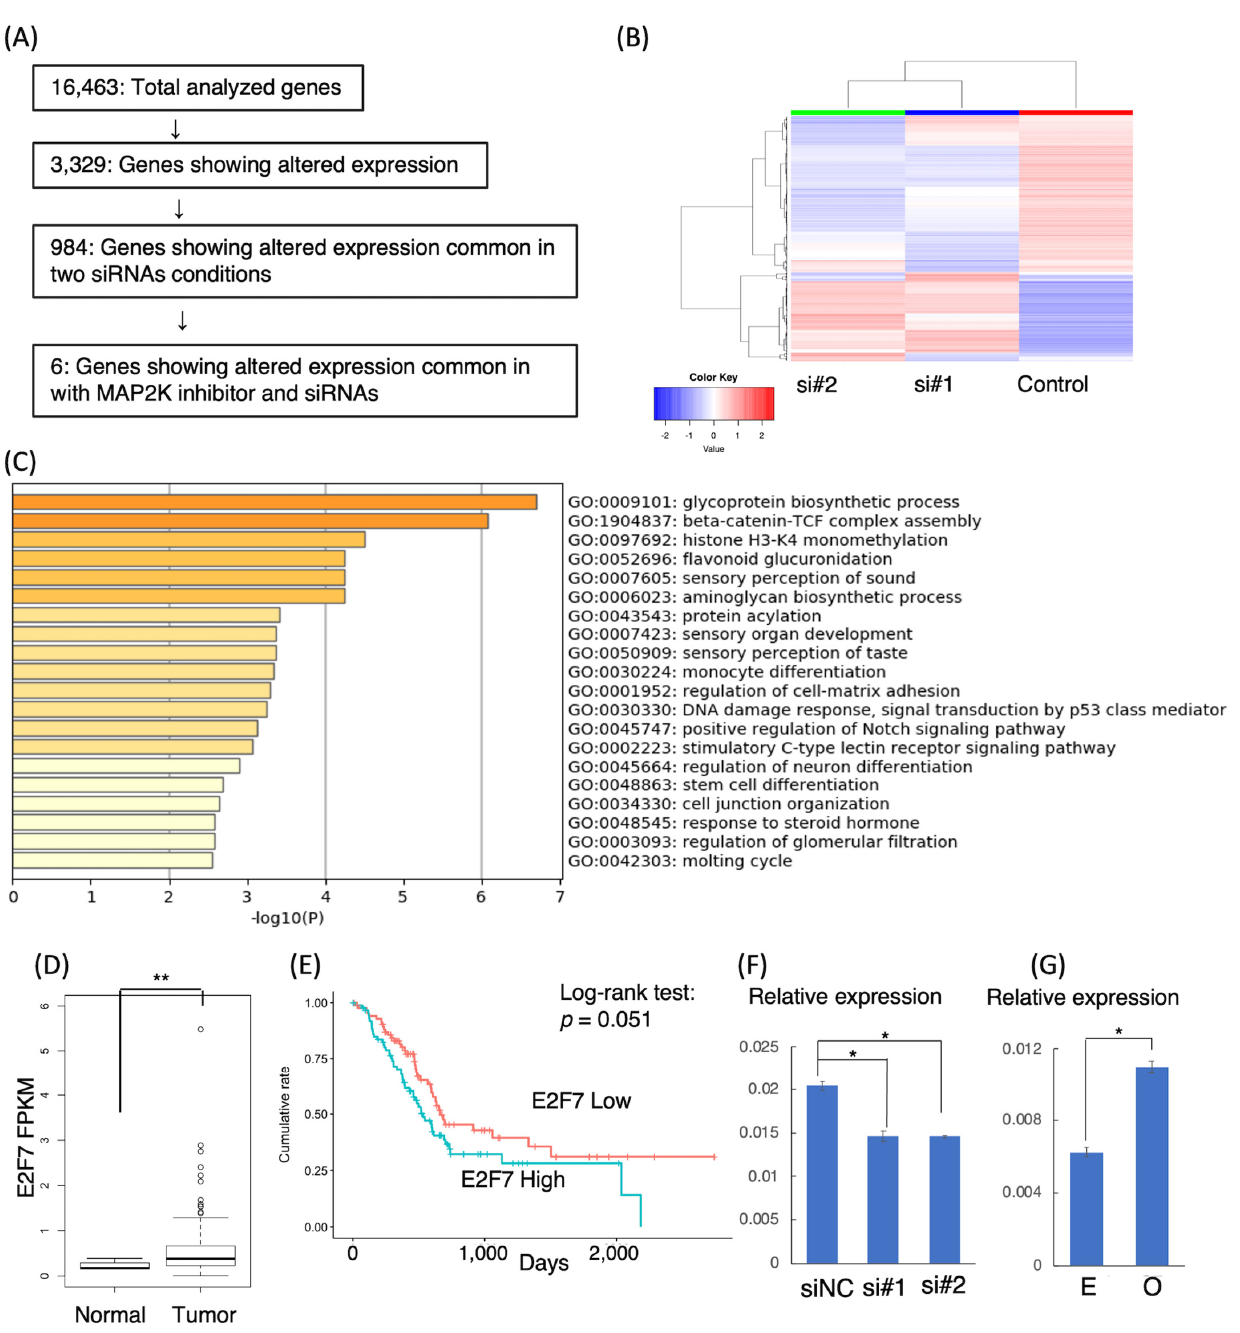
Figure 4. Identification of genes associated with LINC00941. ( A ) Stringent processing of comparative transcriptome sequencing data of AsPC-1 with or without attenuation of the expression of LINC00941 . ( B ) Heatmap with hierarchical clustering showing comparison of transcriptome data between cells with siRNAs for LINC00941 and negative control. ( C ) Top 20 Gene Ontology Biological Process terms of genes associated with LINC00941. ( D ) TCGA data analysis showed that pancreatic cancer tissues revealed higher expression of E2F7 than normal tissues (** p < 0.001). ( E ) TCGA data analysis showed the marginal survival difference between patients with pancreatic cancer with higher and lower expression of E2F7 ( p = 0.051 by log-rank test). ( F ) qRT-PCR validated the transcriptome data showing downregulation of E2F7 by knockdown of LINC00941 in AsPC-1 (* p < 0.05). ( G ) qRT-PCR showed that overexpression of LINC00941 in AsPC-1 resulted in upregulation of E2F7 (* p < 0.05). Abbreviations: E, empty vector; O,